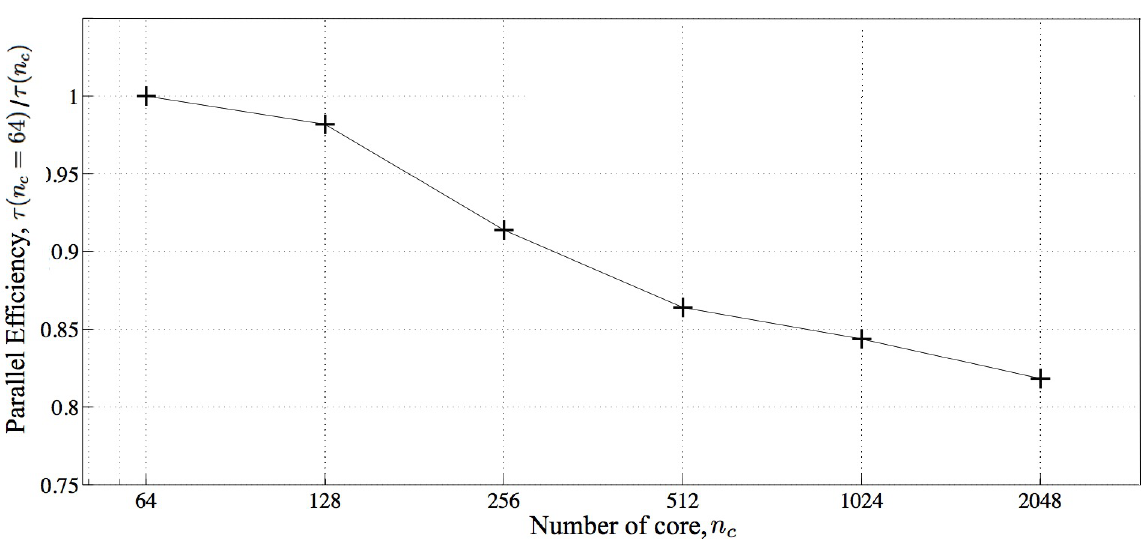
Figure A2. Weak scaling test of the RBC 4 case (Table 4) using a fixed meridional grid mesh n = 46 , 565 nodes, and varying number of Fourier modes, n composed of n p efficiency is measured by taking the ratio of the computing time required to perform 1000 = n × n = 64 cores, and the computing time required iterations for the referential case, n c F S to perform 1000 iterations for each n case performed in the c